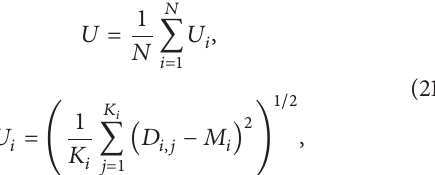
Figure 3: Node deployment environment and initial